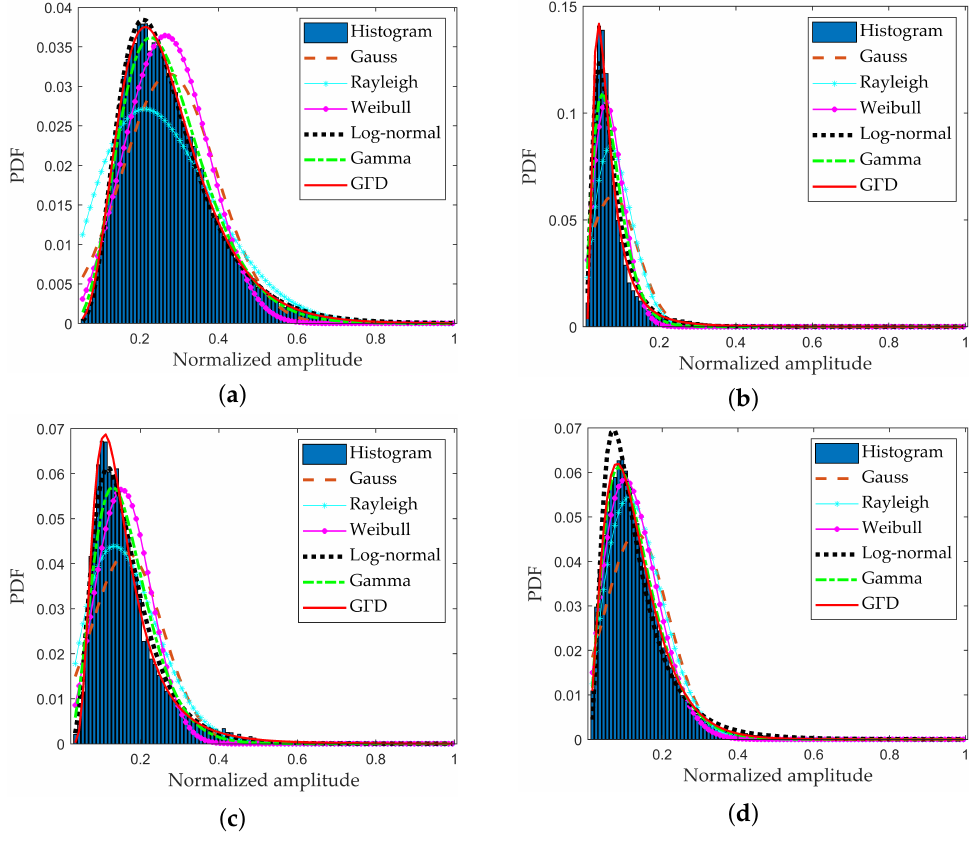
Figure 4. Fitting results of different regions. ( a ) fitting result of region C1; ( b ) fitting result of region C2; ( c ) fitting result of region C3; ( d ) fitting result of region